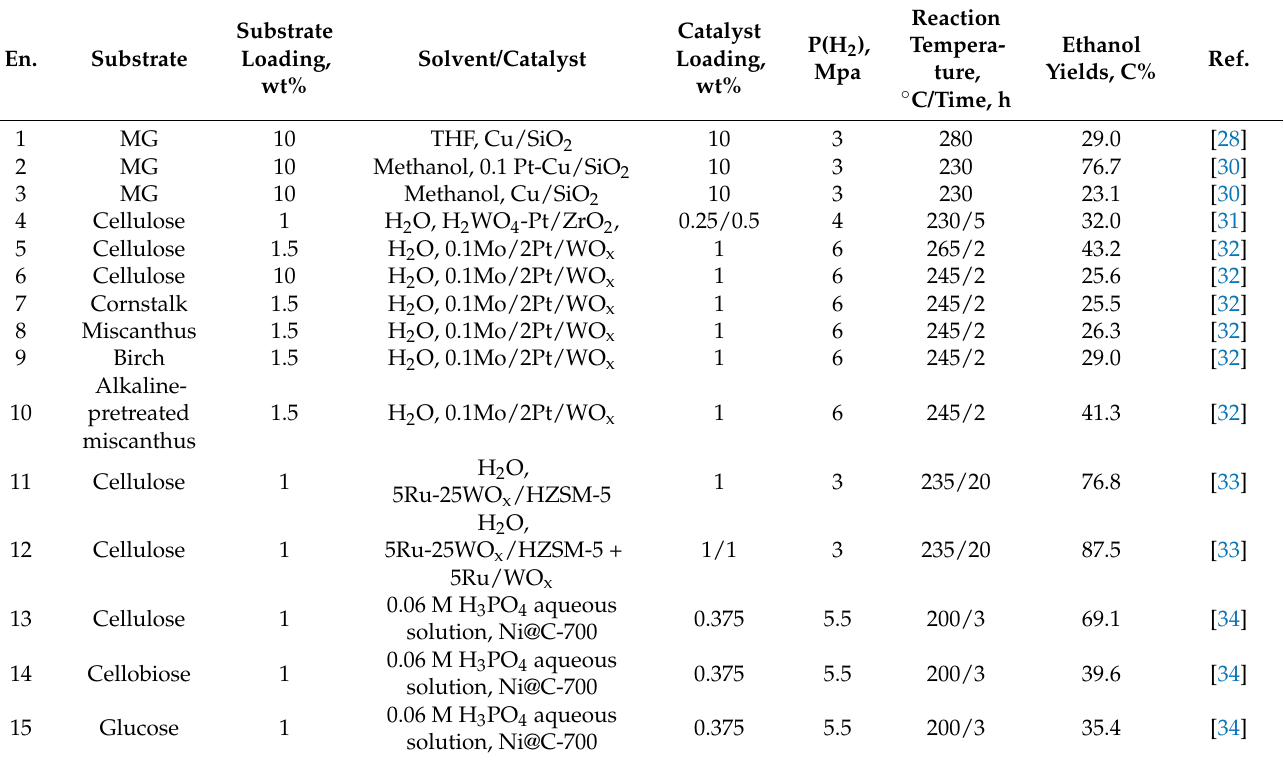
Figure 2. The two-step process towards chemocatalytic conversion of cellulose into ethanol. ( a ) The formation of intermediate MG from cellulose; ( b ) the conversion of MG into ethanol via hydrogena- tion. Table 1. Chemocatalytic conversion of biomass-derived carbohydrates to ethanol.